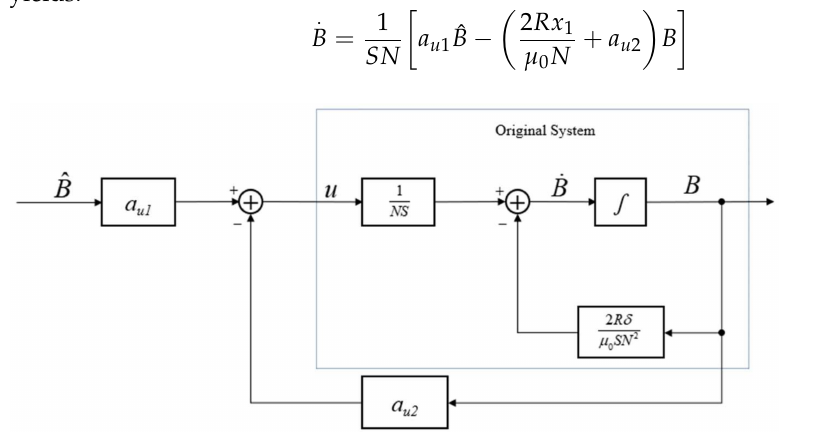
Figure 10. Block diagram of the magnetic flux